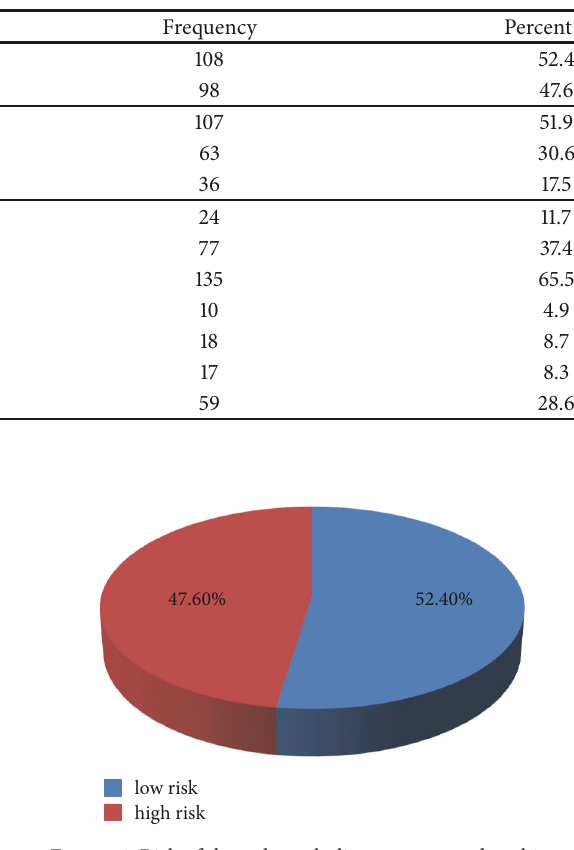
Table 1: Sociodemographic and clinical characteristics of study subjects.